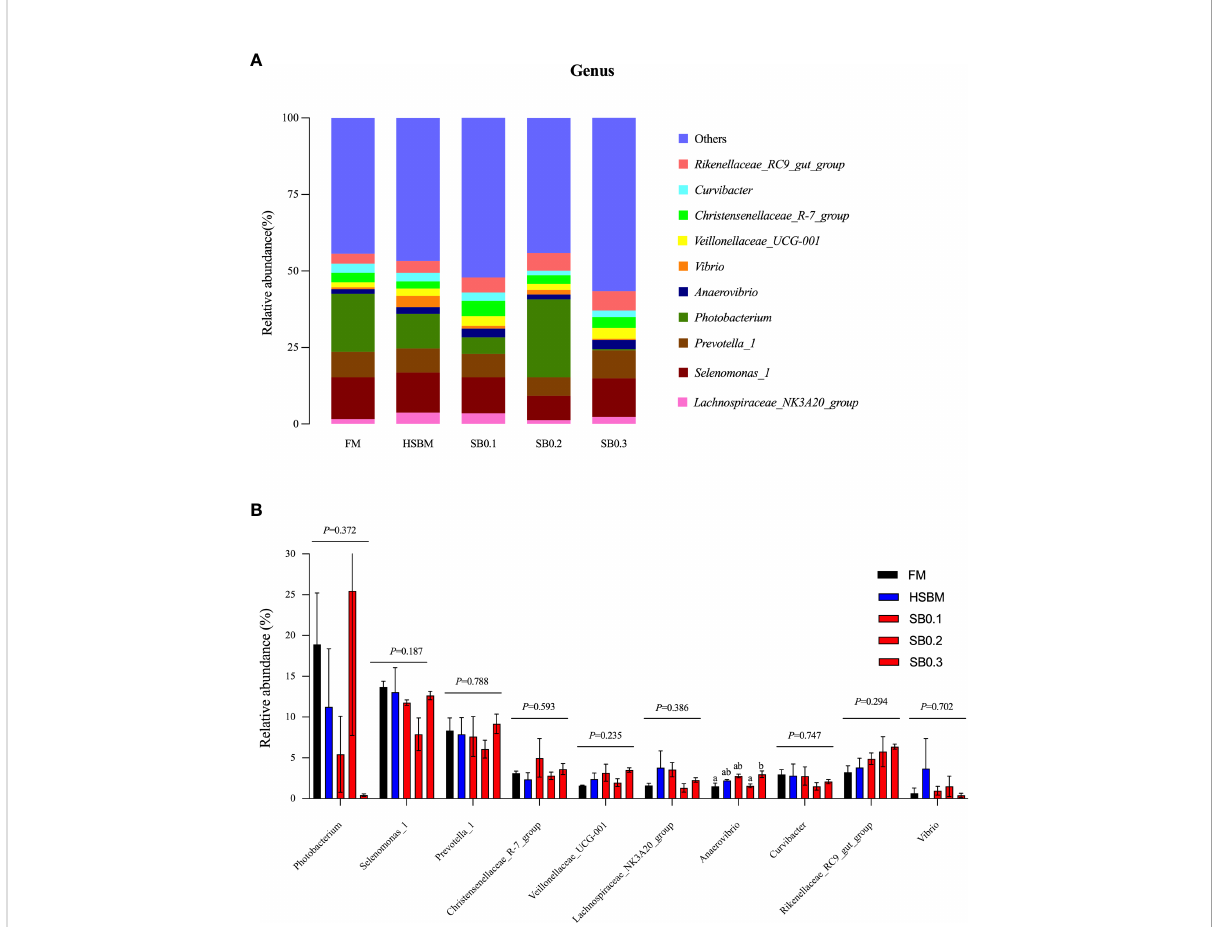
FIGURE 5 Relative abundance of the dominant bacterial genus in different samples in distal intestine of E. coioides. (A) Intestine microbial composition at genus level, (B) Differential analysis at genus level. Bars bearing the different letters indicate signi fi cant differences ( P < 0.05), while that with the same letters indicate no signi fi cant difference ( P > 0.05). Data are presented as the means of per dietary treatment (n = 3 tanks). FM, fi sh meal; HSBM, 60% FM protein replacement with SBM in FM diets without SB addition; SB0.1, SB0.2 and SB0.3, 0.1%, 0.2%, and 0.3% SB were added in the HSBM diets,